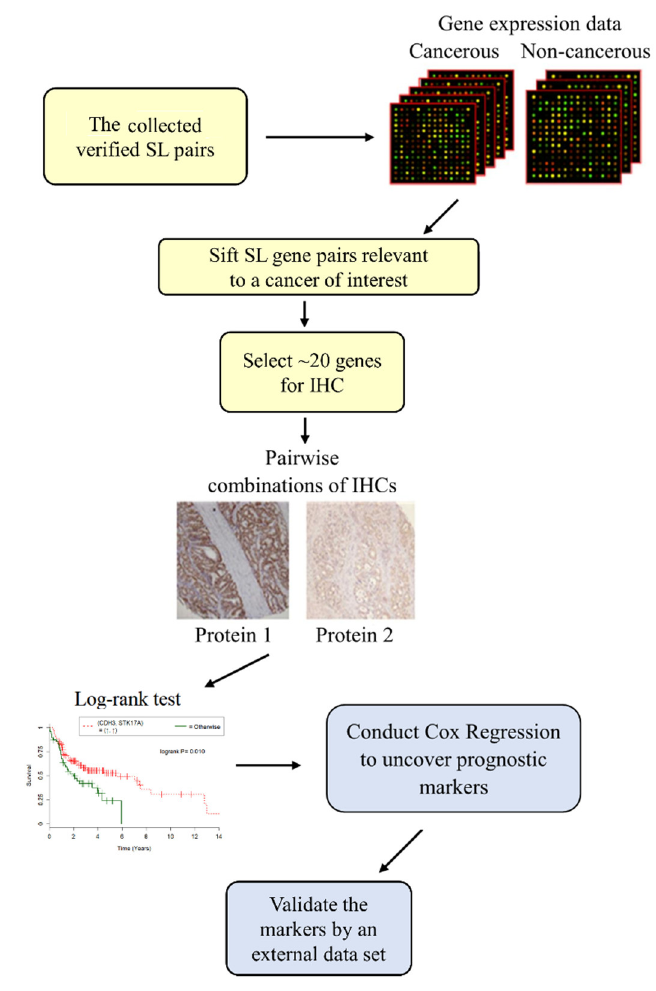
Figure 2. A graphical display of the approach in [31–33] to discover prognostic biomarkers. Gene expression of cancerous versus non-cancerous tissues was used to select SL gene pairs relevant to a cancer under study, from the collected SL pairs. This procedure resulted in ~20 genes for immunohistochemistry (IHC). Then combinations of IHC and overall survival of patients were analyzed by Cox regression to yield prognostic markers, which were further validated by at least one external data set such as TCGA.